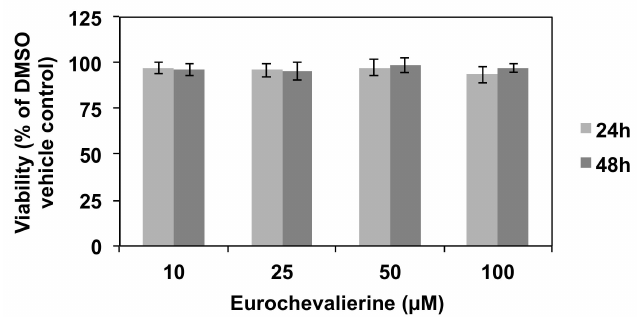
Figure 6. Eurochevalierine does not alter the viability of normal cells. The viability of PBMCs from healthy donors was assessed after 24 and 48 h of treatment at the indicated concentration of eurochevalierine. Results correspond to mean ± SD of three independent